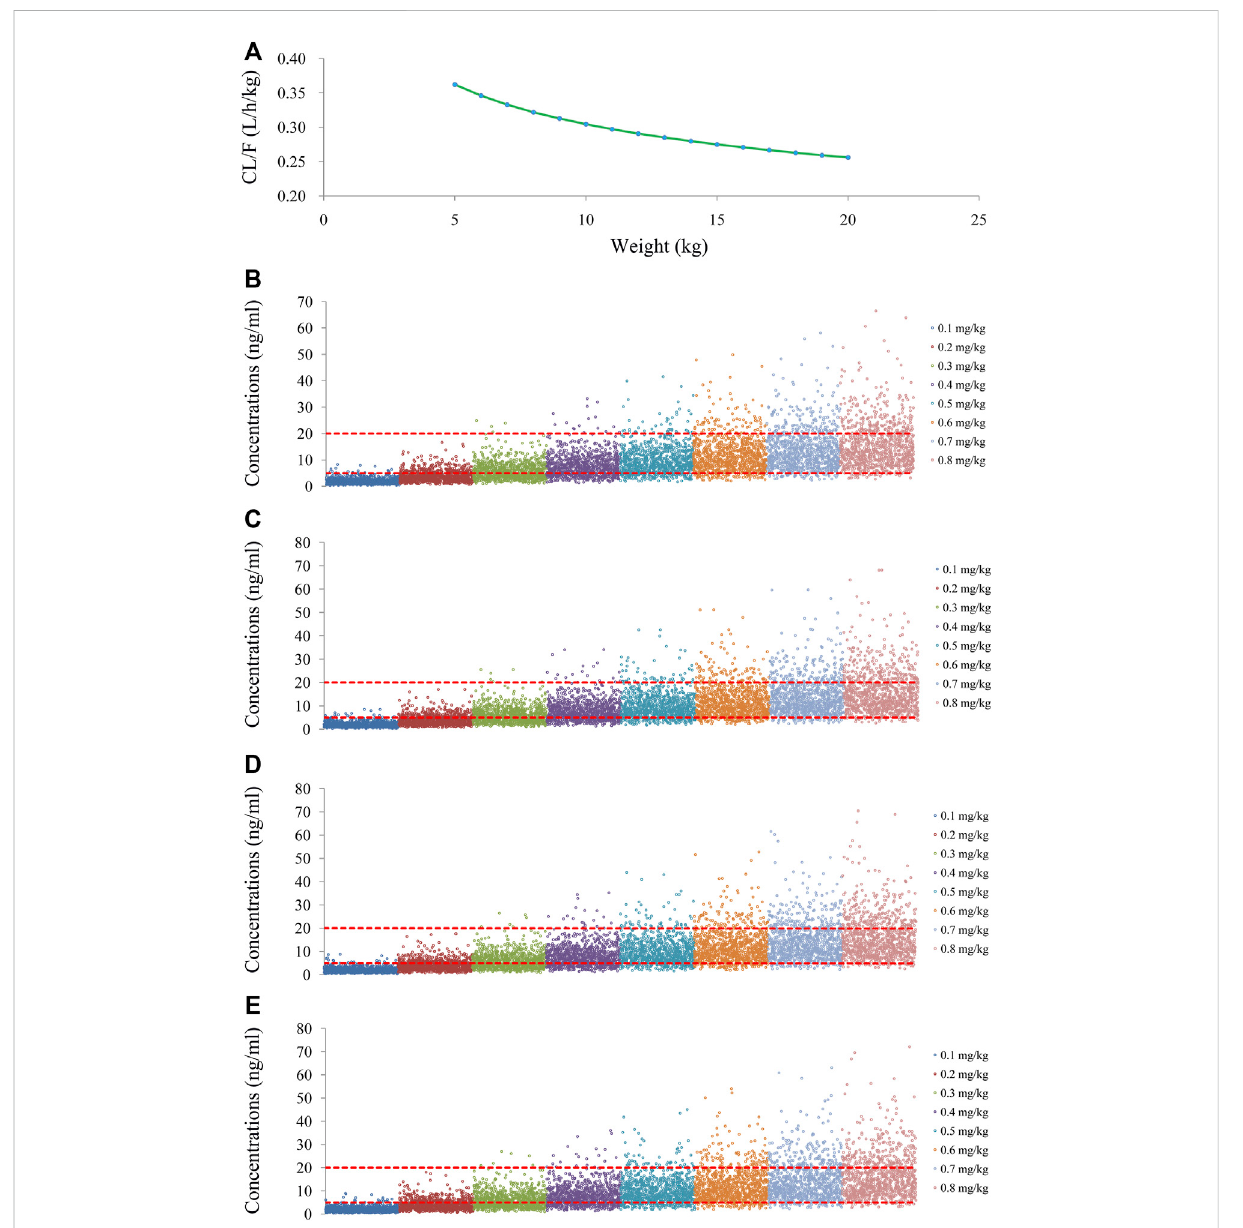
FIGURE 3 Tacrolimus CL/F and concentration simulation. (A) CL/F of tacrolimus in SCID undergoing HSCT. (B) Pediatric patients weighing 5 kg. (C) Pediatric patients weighing 10 kg. (D) Pediatric patients weighing 15 kg. (E) Pediatric patients weighing 20